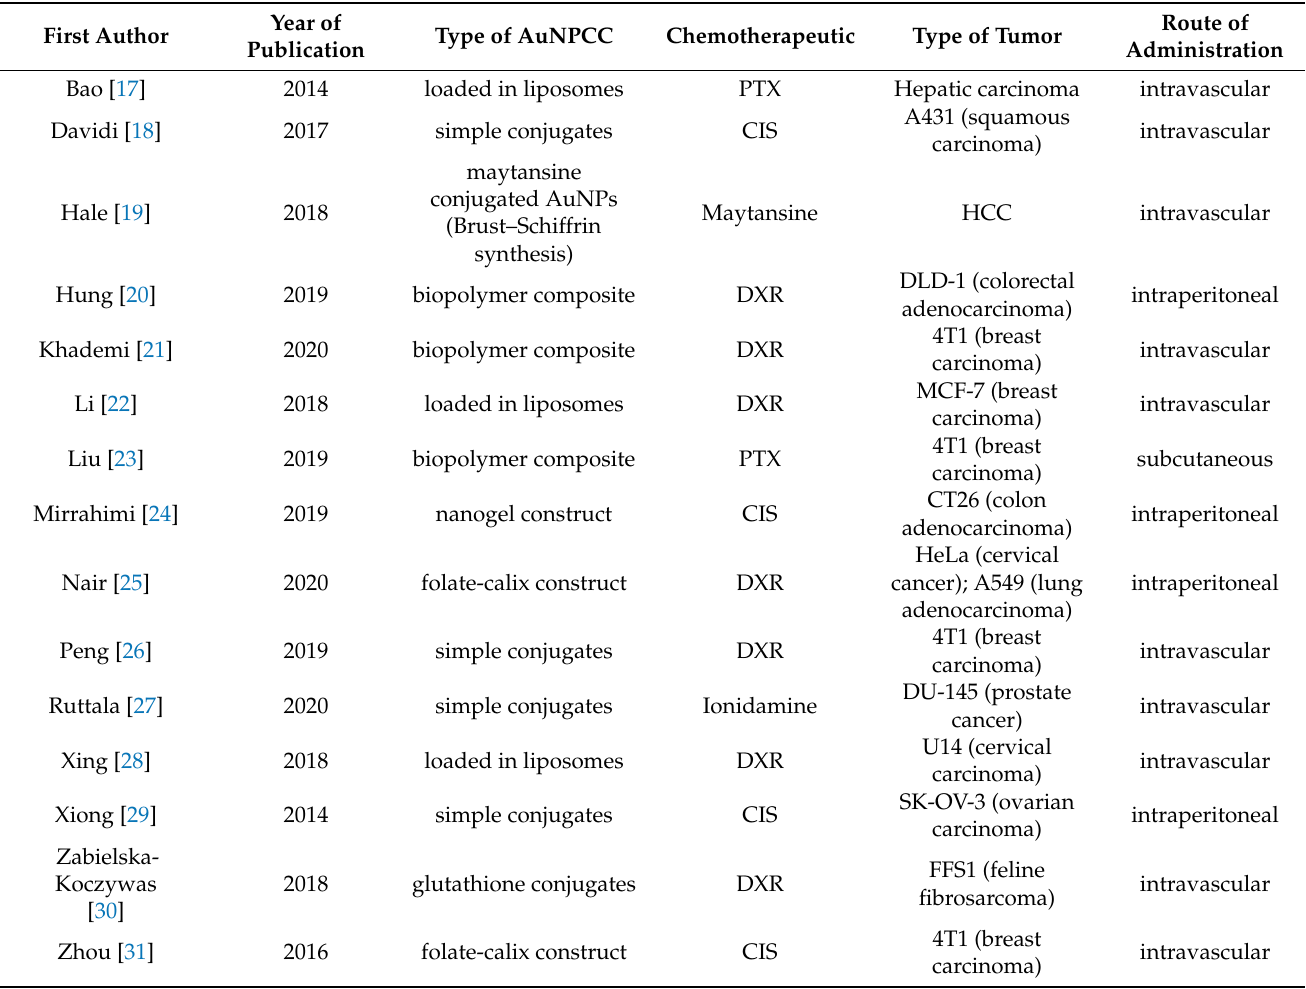
Table 2. Overview of included